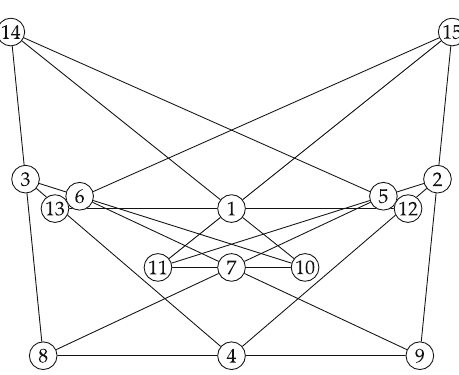
Figure 10: The unique 15 330 - con fi